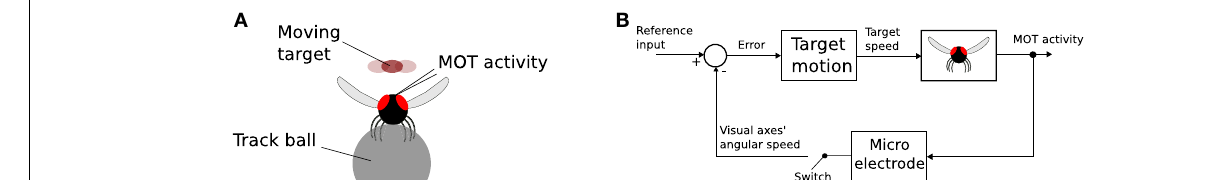
closed-loop scheme presented here, a second feedback-loop has been added to that proposed by Northrop and Qi (see Figure 3 ): in this case, the input signal is the target speed and the output signal is the angular speed of the visual axes.The switch makes it possible to open or close the feedback loop, depending on the experimental procedure